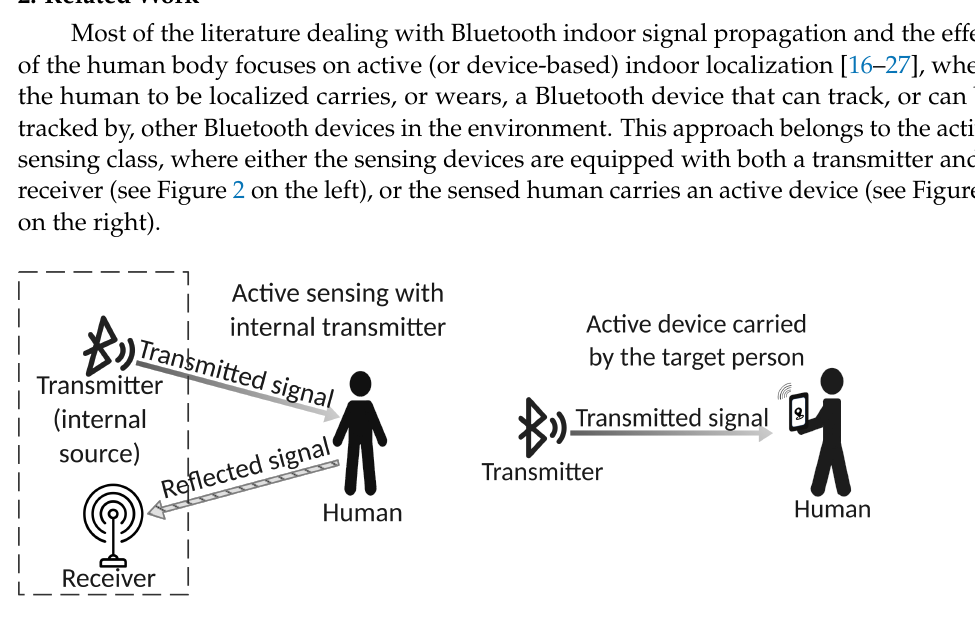
Figure 2. Two classes of active sensing. On the left , the sensing device is equipped with both internal probing signal transmitter and receiver. On the right , the sensed human brings an active device that receives the probing signal and produces the sensing